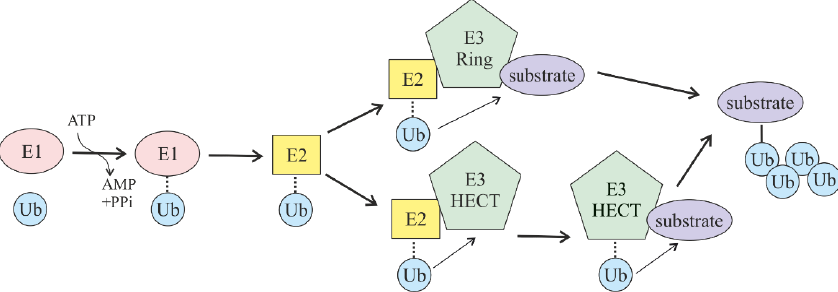
Figure 1. Scheme of protein substrate ubiquitylation. This pathway requires ubiquitin (Ub) and the availability of Ub-activating (E1), Ub-conjugating (E2), and Ub-ligating (E3) enzymes. Two major classes of Ub-ligating enzymes, really interesting new gene (RING)- and homologous to the E6-AP carboxyl terminus (HECT)-domain-containing E3 ligases, are presented. Cells 2019 , 8 , x FOR PEER REVIEW